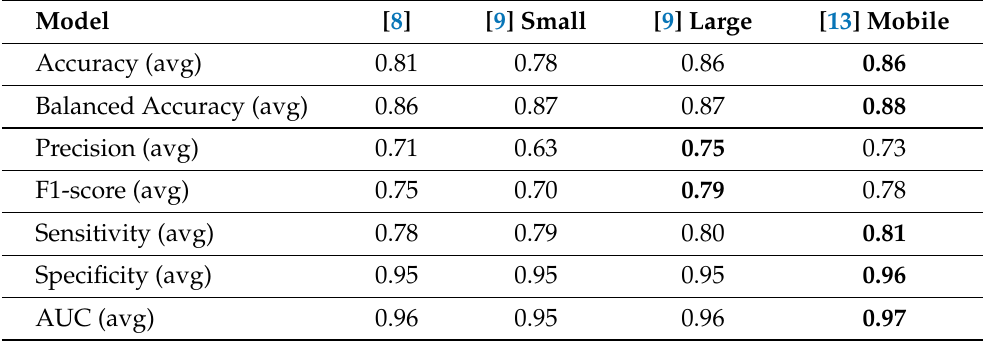
Table A5. Deeper analyzing of the mobile model. This table illustrates the other indicators of the four mobile-based models including MobileNetV2, MobileNetV3Small, MobileNetV3Large, and NasNetMobile. The indicators are Accuracy, Balanced Accuracy, Precision, F1-score, Sensitivity, Specificity, and AUC. All of them are average